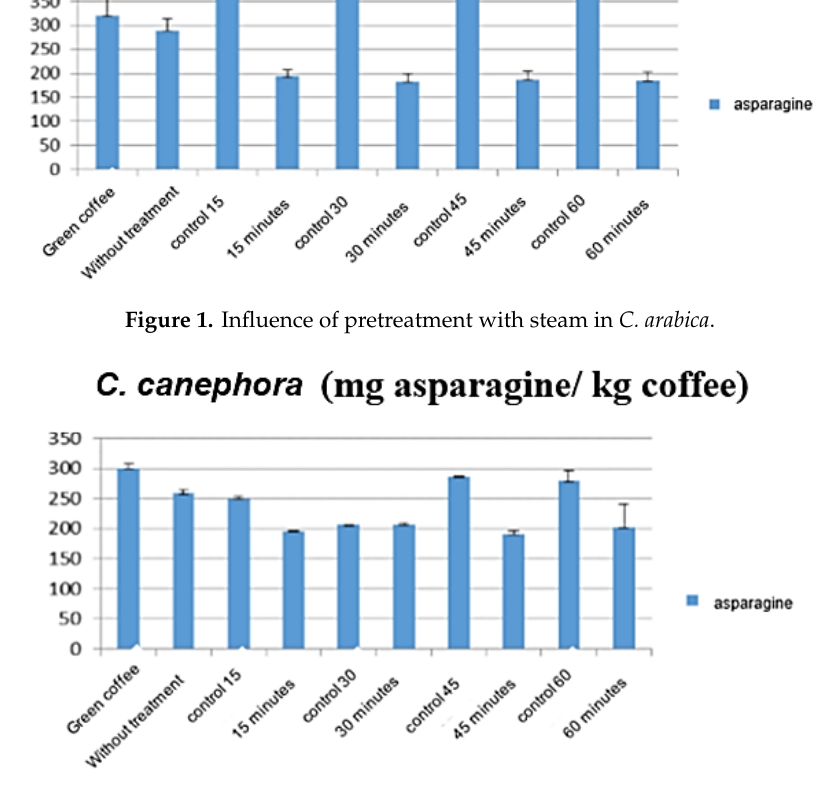
Figure 2. Influence of pretreatment with steam in C. canephora .